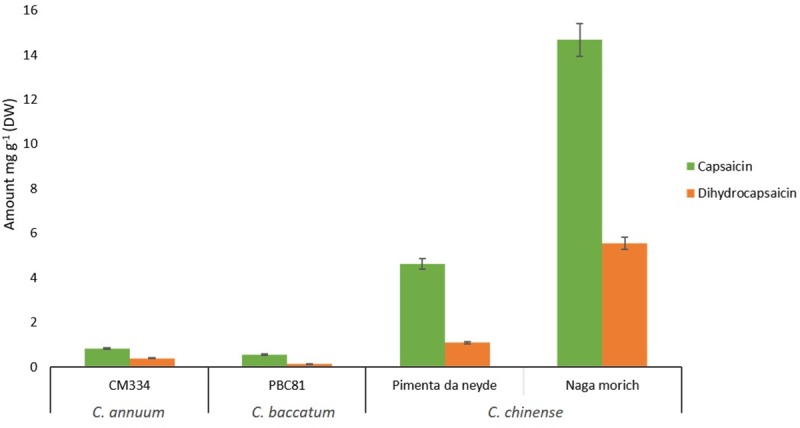
Capsaicin and dihydrocapsaicin content in pepper.Capsaicin and dihydrocapsaicin levels in pepper powder from dried green fruit (16 days post anthesis (dpa)). Values are means ± SD; n = 3.